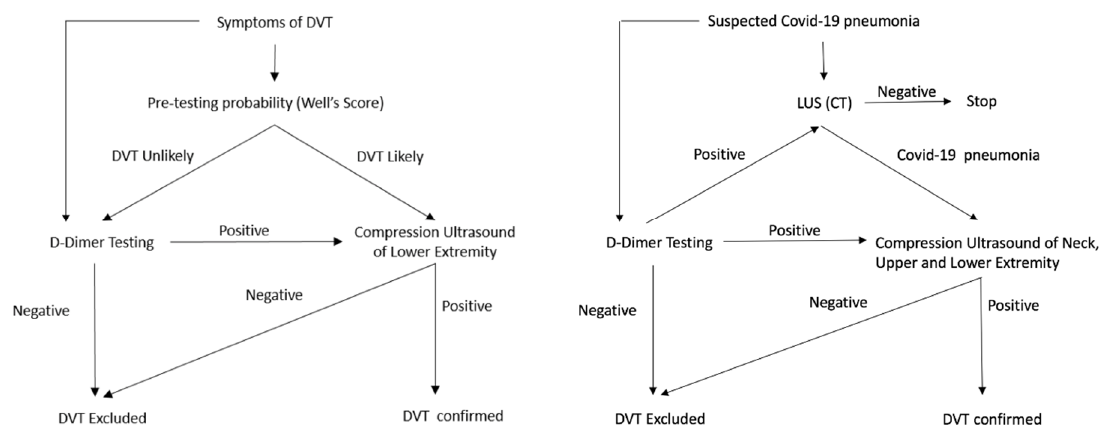
Figure 5. Current diagnostic flowchart for suspected DVT as compared to diagnostic flowchart for suspected COVID-19. ( Right ) current diagnostic flowchart used in case of suspected DVT. ( Left ) in the COVID-19 era, the flowchart for suspected patients would include both D-dimer and LUS. Positive cases should be immediately investigated for DVT by CUS at the level of the neck, upper, and lower extremities, respectively.